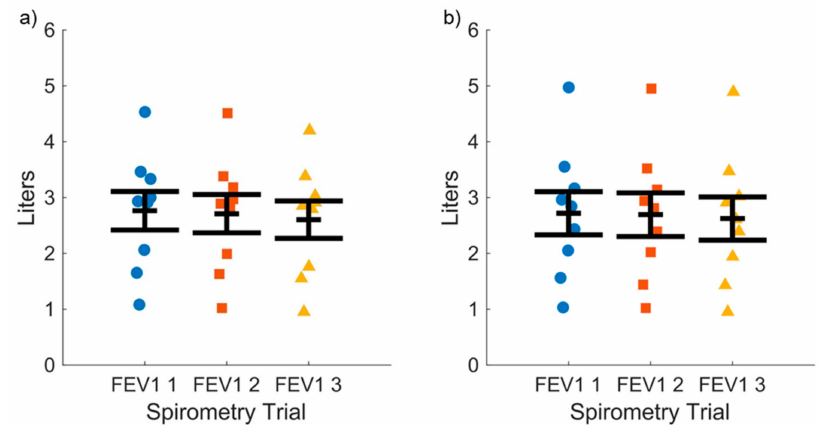
Figure 3. Forced expiratory volume in 1 s (FEV1) values measured across three consecutive vital capacity maneuvers for asthma subjects for: ( a ) Spirometer function of our novel platform; and ( b ) a commercial bench-top traditional spirometer. Mean ± SEM values for the novel and traditional spirometer are